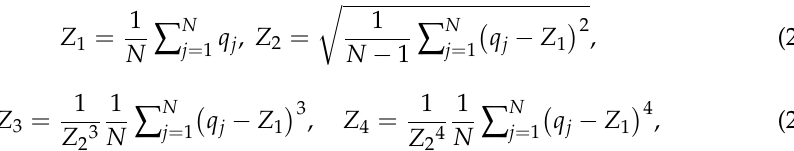
M 41 ( b ) and their corresponding histograms ( c , d ).